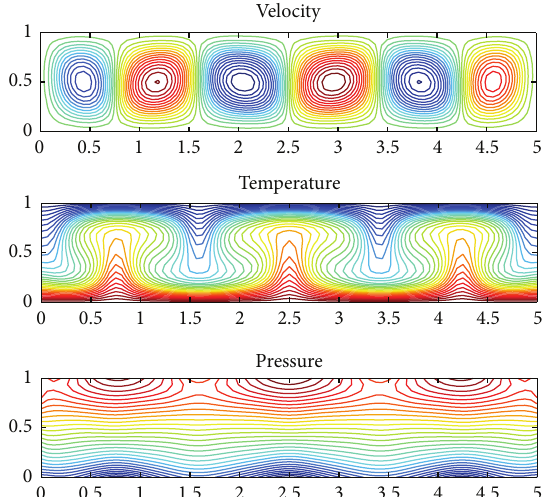
Figure 2: Example 20: streamlines of velocity and isolines of temperature and pressure, at time 𝑡 = 1.0 . The nondimensional parameters are 𝜅 = 10 4 , 𝜆 = 1 , 𝜇 = 1 , and the discretization parameters are 𝜏 = 10 −2 , ℎ = 2 −4 .